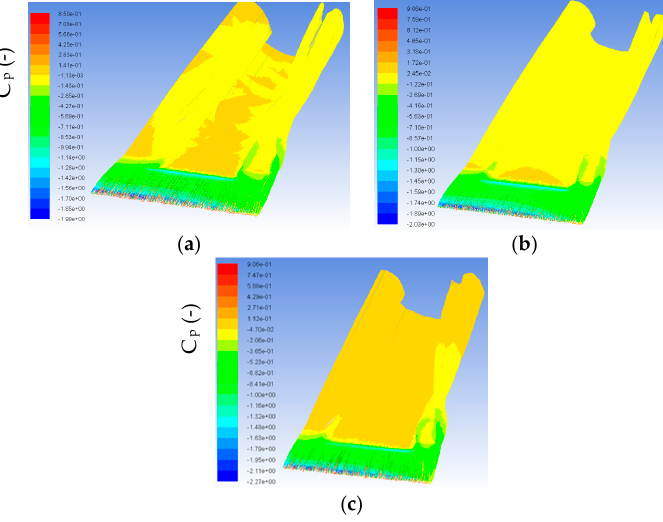
Figure 24. Images showing pressure coefficient for the flow over ( a ) the conventional wing; ( b ) Initial morphing wing; ( c ) optimized morphing wing all at 5 degrees’ angle of attack.